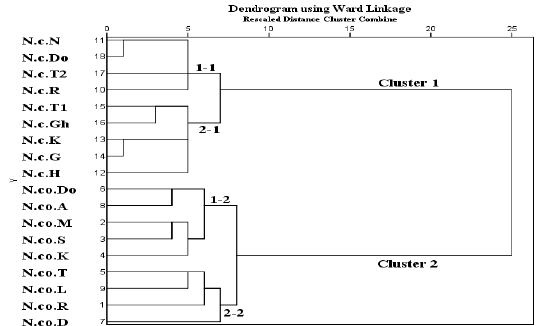
Fig. 8. Cluster dendrogram for isoenzymes analysis of 18 samples of N . complanata and N. crispa based on the Euclidean distances have been shown in Table